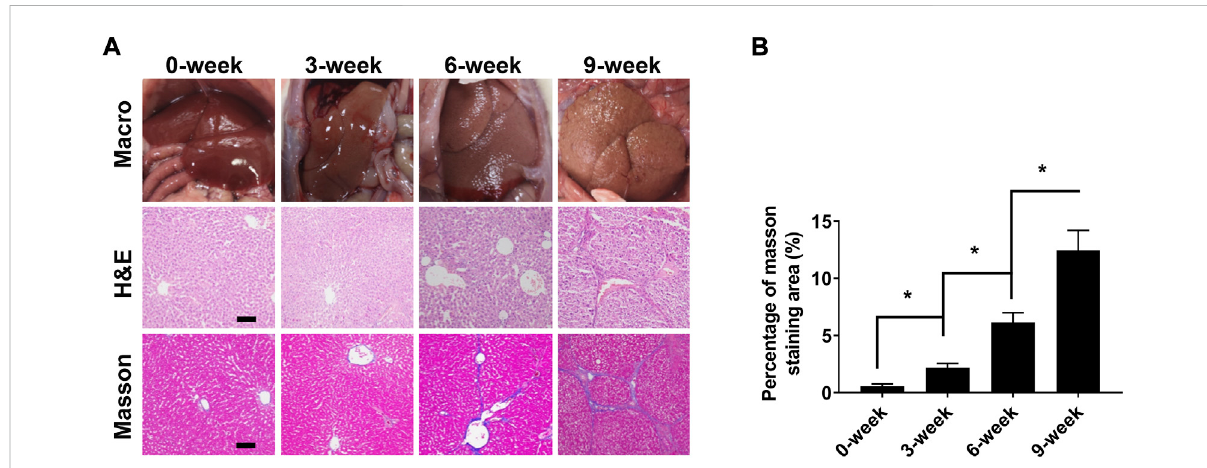
FIGURE 6 Liver fi brosis stage analysis after 0, 3, 6, and 9 weeks of CCl 4 induction. (A) Macroscopic inspections and pathological examination of the liver fi brosis and control groups (×100; Scale: 100 μ m). (B) Semi quantitative analysis of Masson ’ s trichromestaining ( fi brosis) in normal and fi broticlivers. * p <